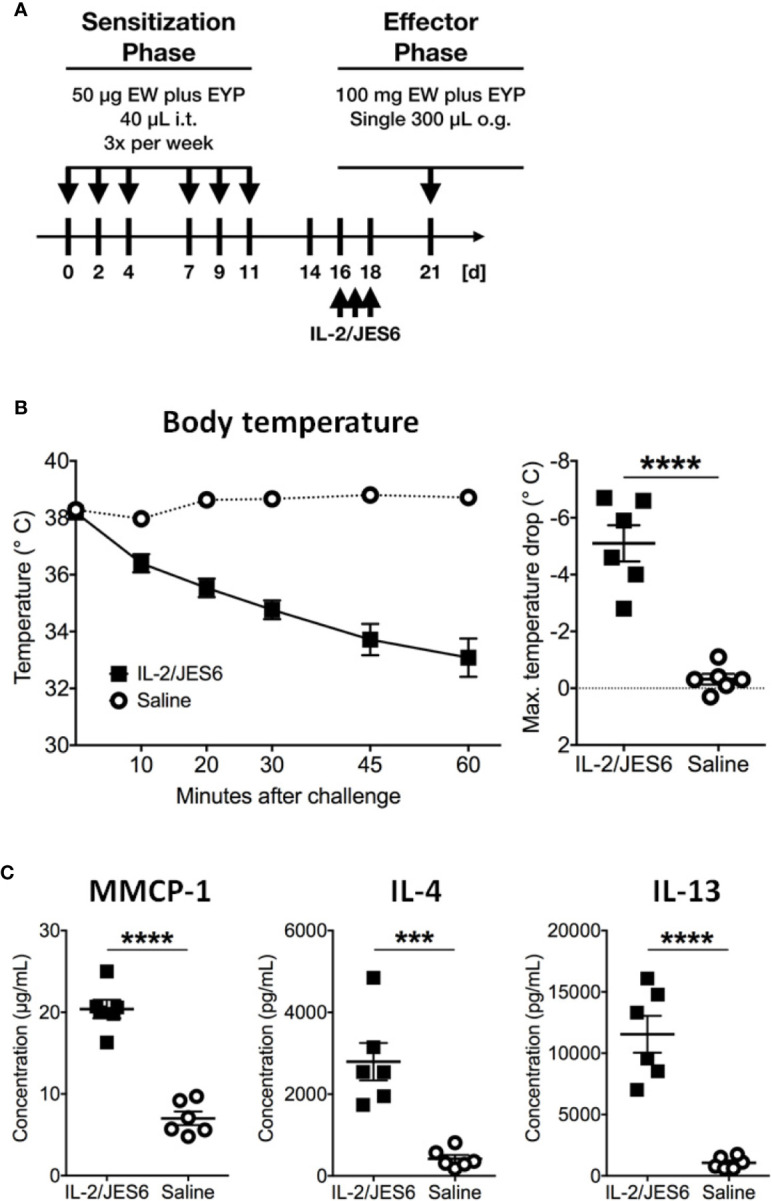
IL-2/JES6 treatment after allergen sensitization. Mice were treated with IL-2/JES6 after sensitization and before the first challenge. (A) Treatment regimen. (B) Rectal temperature curve (left) and maximal temperature drop (right) after antigen challenge. (C) Serum mMCP-1 as assessed by ELISA. IL-4 and IL-13 were measured by IVCCA. Data shown represent mean ± SEM (n = 6). ***p < 0.001, ****p < 0.0001 (Student’s t-test).